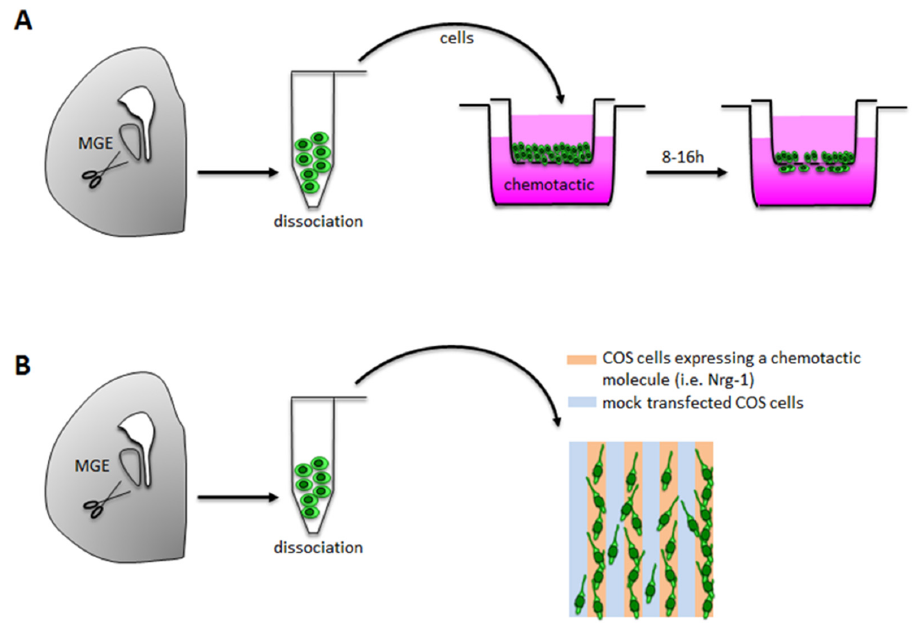
Figure 2. In vitro techniques to study interneuron migration. Primary dissociated interneurons are obtained from MGE explants by enzymatic and mechanical dissociation. ( A ) Transwell/Boyden chamber assays are based on an upper compartment (light pink) containing primary neurons and a lower compartments containing the chemotactic molecule creating a gradient from the bottom to the top of the well (dark pink); compartments are separated by a porous membrane through which neurons migrate; migration rate is evaluated after 8–16 h of incubation. ( B ) Stripe choice assay is based on monolayers of transfected (light orange) and mock transfected (light blue) COS cells; primary interneurons are plated and differentially migrate on stripes, with a preference for stripes of transfected COS cells if expressing a chemoattractant.